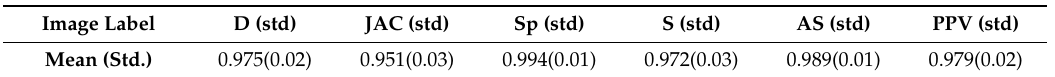
Table 1. Results of the Dice (D), Jaccard Index (JAC), precision (PPV), sensitivity (S), specificity (Sp) and accuracy segmentation (AS), along with the standard deviation (std), for the segmentation method for 50 MRI